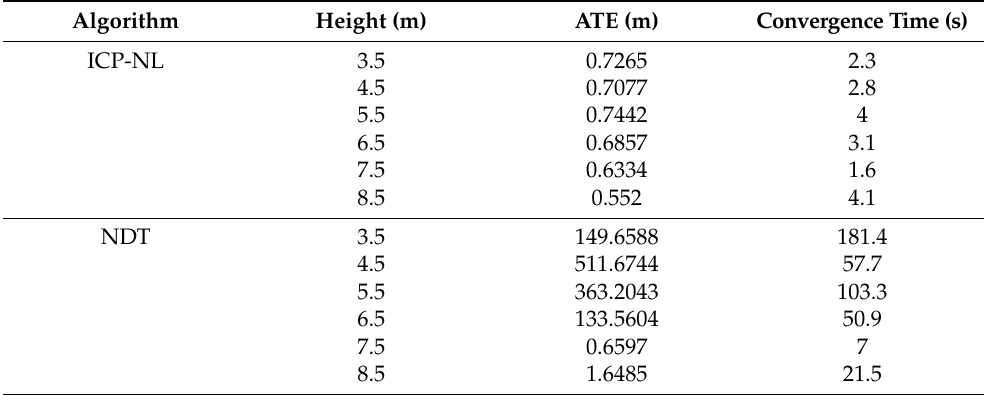
Table 8. Aircraft simulation position estimation errors for ICP-NL and NDT algorithms for different